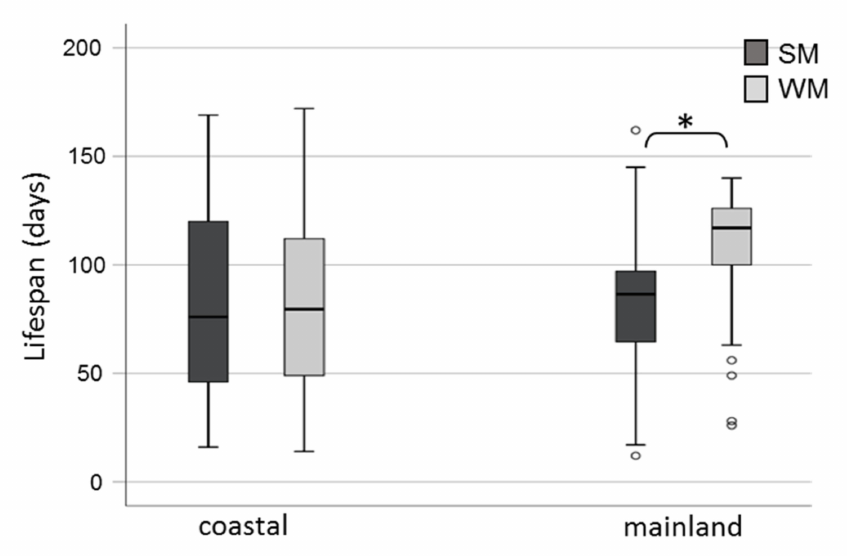
Figure 3. Lifespan (boxplots) of D. suzukii SM and WM exposed to field conditions in a coastal area of central Greece (Volos) and a mainland area of northern Greece (Naousa) from 1 November 2019 until the death of all individuals in May 2020. Values within the chart below the asterisk differ significantly ( p < 0.05). Circles depict outliers (numerically distant values from the rest of the